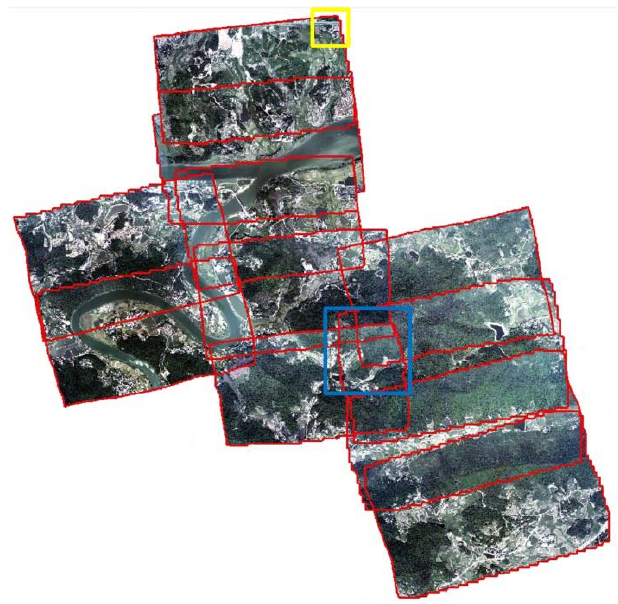
Figure 5. Data Set 1.